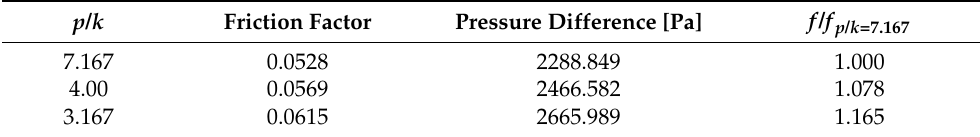
Table 5. Pressure difference and friction factor for different p / k in a single